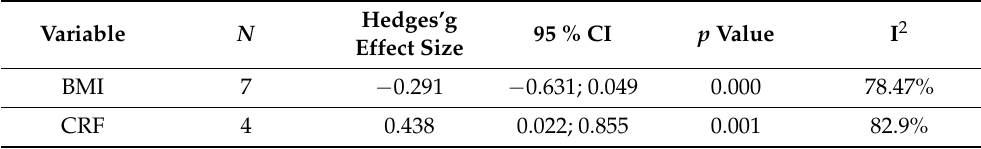
Figure 2. BMI effect sizes for AVG compared with control group. Subgroup analysis by AVG intervention’s length; Subgroup 1: AVG interventions lasting less than 18 weeks; Subgroup 2: AVG interventions lasting 18 weeks or more. Table 4. Effect sizes and heterogeneity of findings for studies comparing AVG intervention versus control